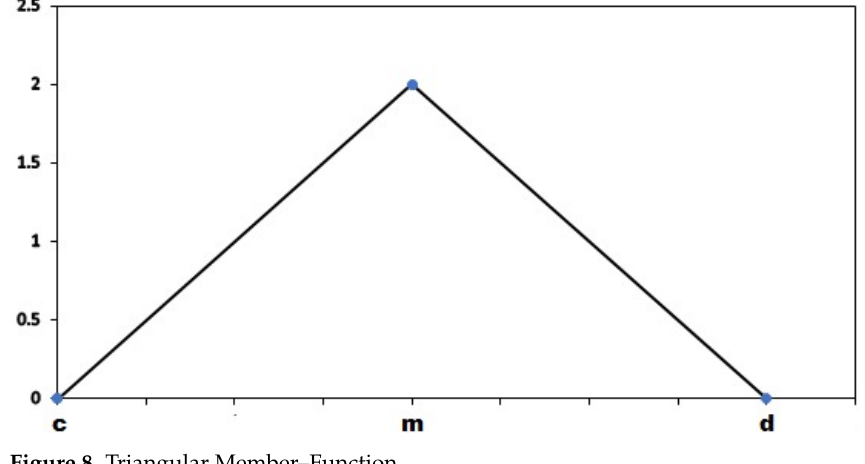
Figure 8. Triangular Member–Function.